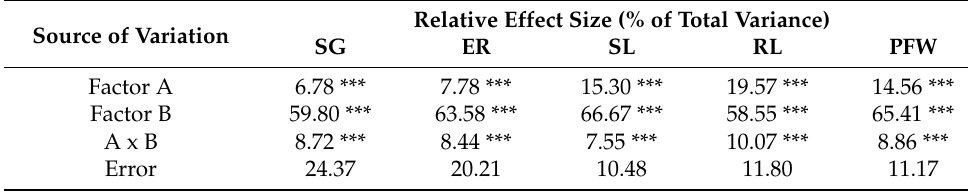
Table 2. Two-way analysis of variance for the influence of genotype (Factor A) and NaCl concen- tration (Factor B) on the response of 22 garden pea genotypes under four levels of salinity in vitro: seed germination (SG), emergence rate (ER), shoot length (SL), root length (RL), plantlet fresh weight (PFW). Source of